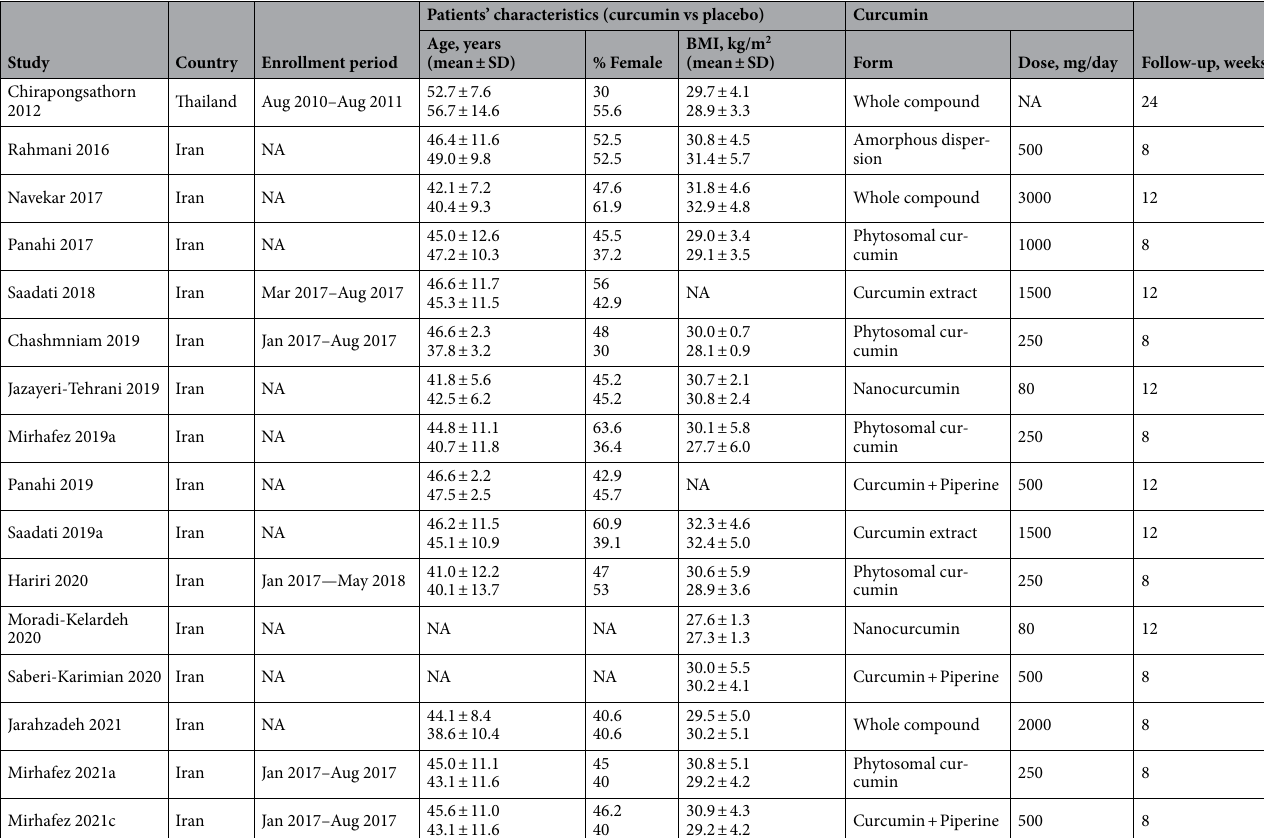
Table 2. Baseline characteristics for the randomized-controlled trials included within the updated meta- analysis. NA not available, SD standard